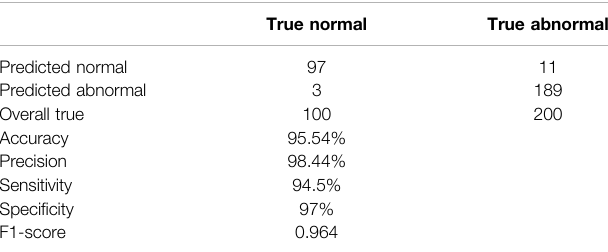
TABLE 1 | Testing results of lesions ’ segmentation